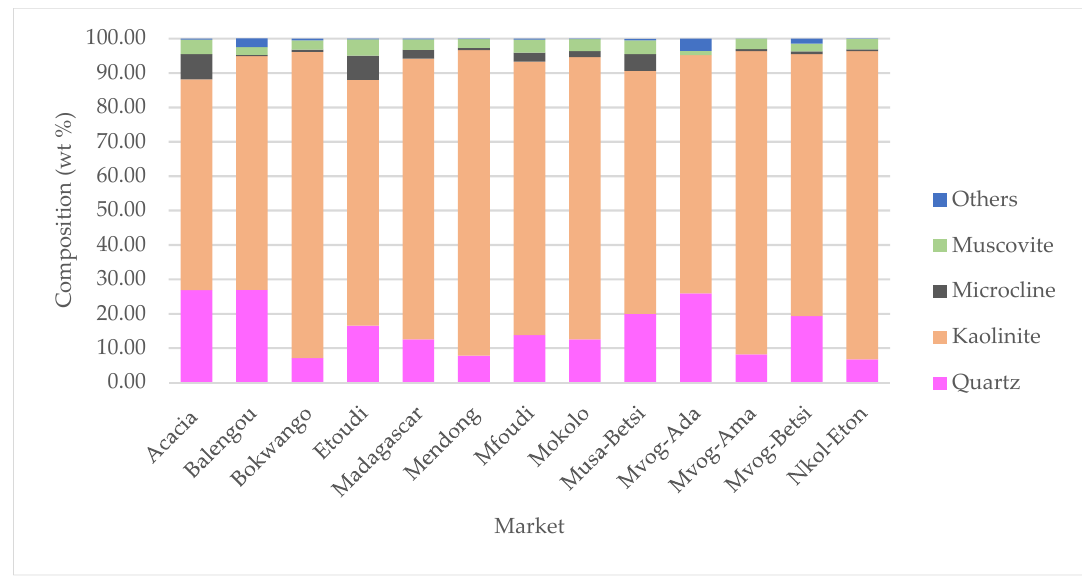
Figure 3. Abundances of mineral phases present in geophagic clays sold in markets in Cameroon. “Others” represent the sum of sepiolite, hematite, gibbsite and goethite.